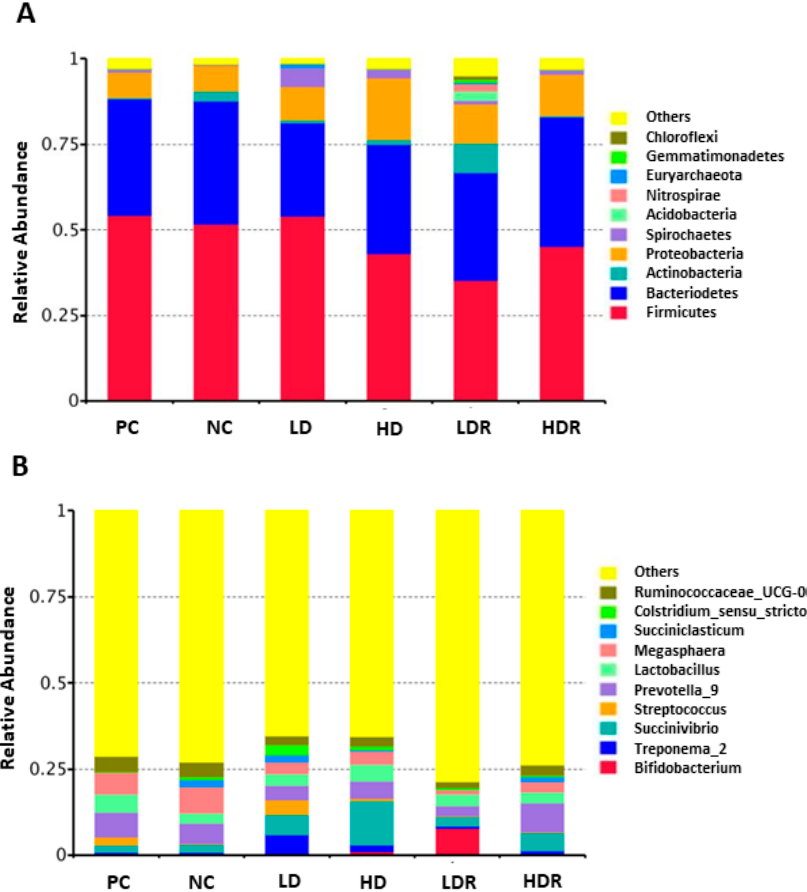
Figure 4. The fecal bacterial composition in pigs fed with low-protein diets supplemented with a corn-expressed phytase. ( A ) the relative abundance of bacterial community composition at phylum level, ( B ) the relative abundance of bacterial community composition at genus level. Pigs are grouped based on their dietary treatments: PC (positive control): normal protein, adequate Ca and available phosphorous (aP), no corn-expressed phytase (CEP) added; NC (negative control): low protein, adequate Ca and aP, no CEP added; LD: NC + CEP added at low dose, i.e., 2000 FTU/kg of diet; HD: NC + CEP added at high dose, i.e., 4000 FTU/kg of diet; LDR: LD with reduced calcium (Ca) and phosphorus (P); HDR: HD with reduced Ca and P. Only the top 10 phyla and genera are shown for clarity. n = 6 for each dietary group.